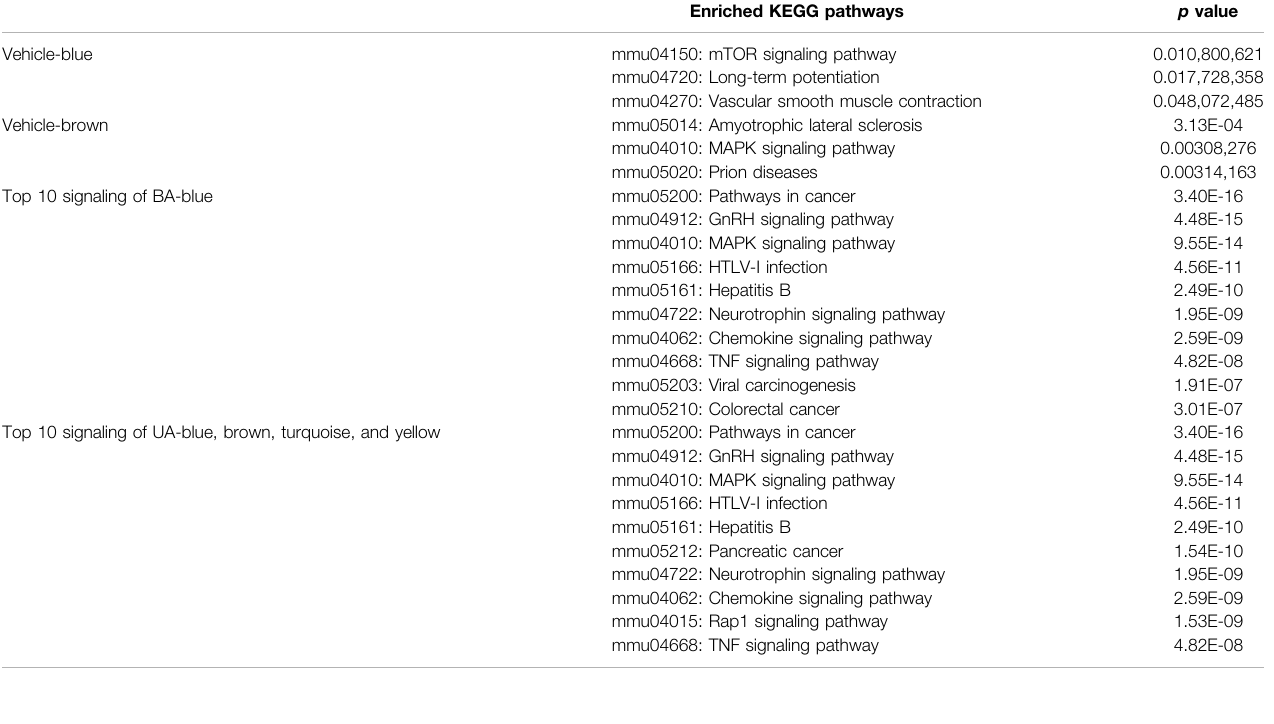
TABLE 3 | Enriched KEGG pathways of the PMP in disease condition, and top 10 KEGG pathways of modules in BA and UA that PMP nodes scattered in.